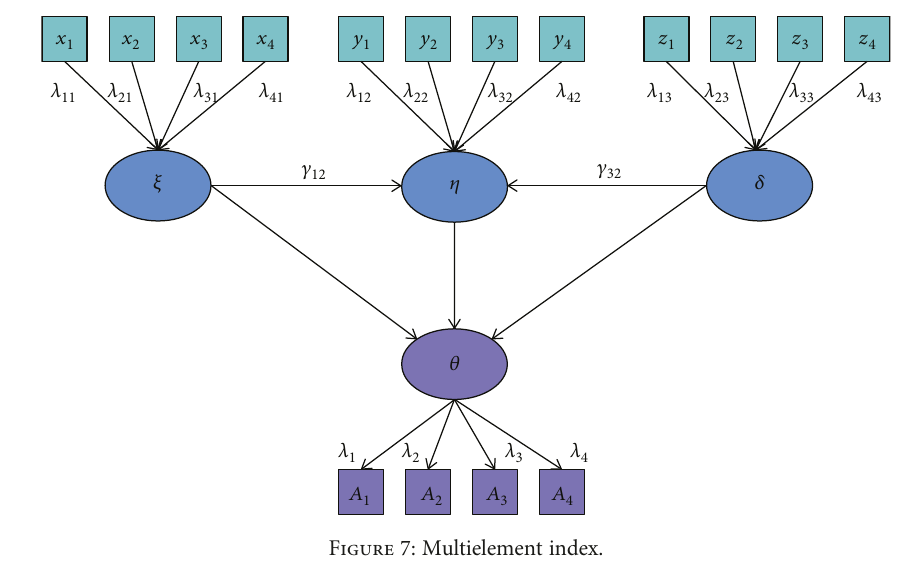
Figure 7: Multielement index. Table 2: Multiple indicators of public awareness of the weight. Risk perception on